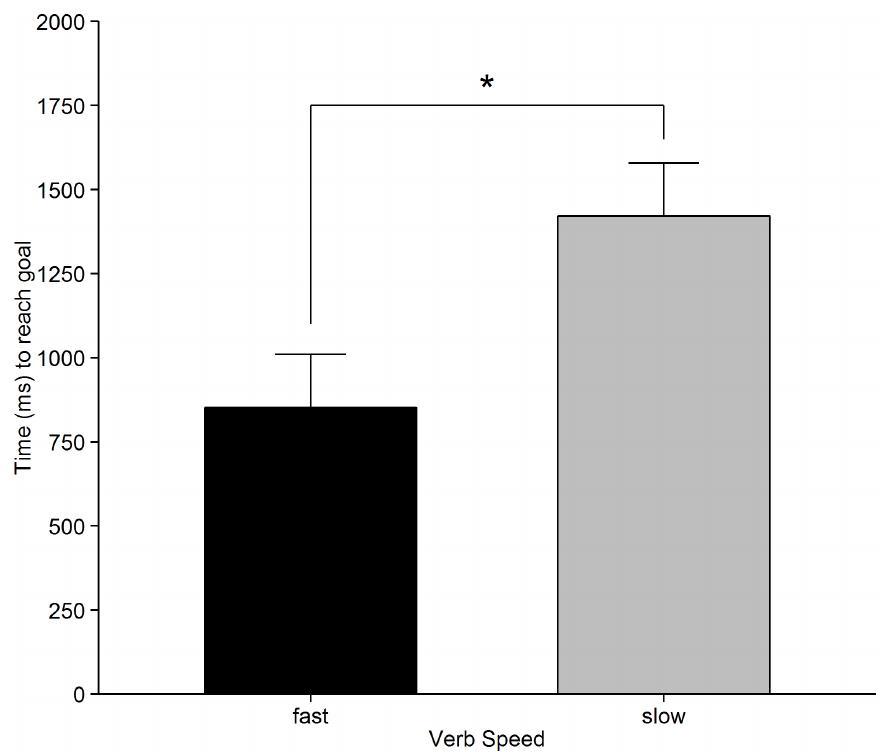
Figure 2. Mean movements times for the movement tracking task. Error bars indicate within-participant 95% confidence intervals [35].